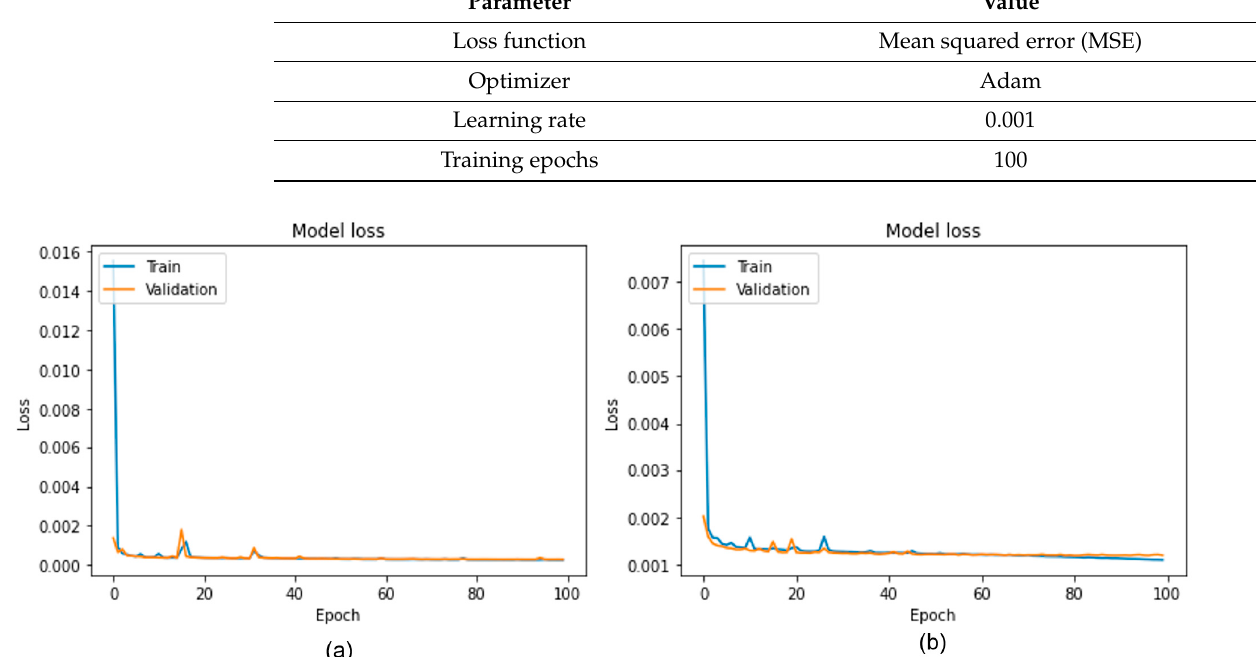
Figure 3. Learning curves from training on the validation datasets: ( a ) dataset A, and ( b ) dataset